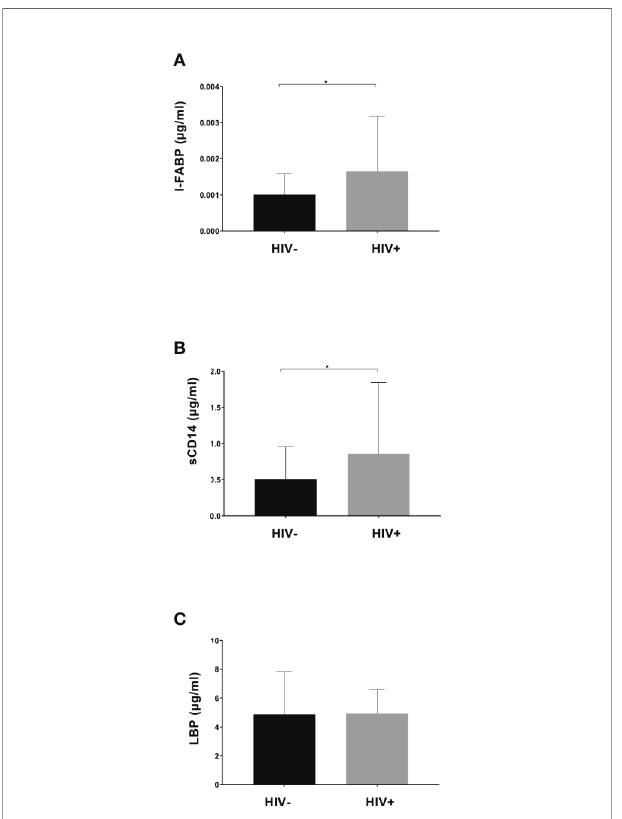
FIGURE 5 | Comparison of plasma markers between HIV-1 uninfected and infected Ghanaian adults. Comparisons of plasma I-FABP (A), sCD14 (B) , and LBP (C) levels are shown. HIV+ (n = 55) showed signi fi cantly higher I- FABP and sCD14 levels than uninfected HIV- (n = 55) ( p < 0.05 [*]; Wilcoxon rank sum